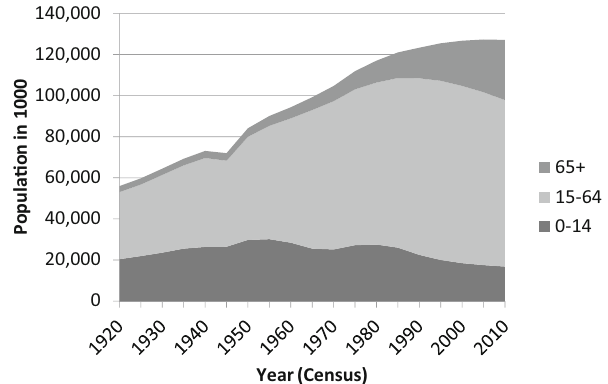
Fig. 1 Population in Japan in three age groups (own drawing based on